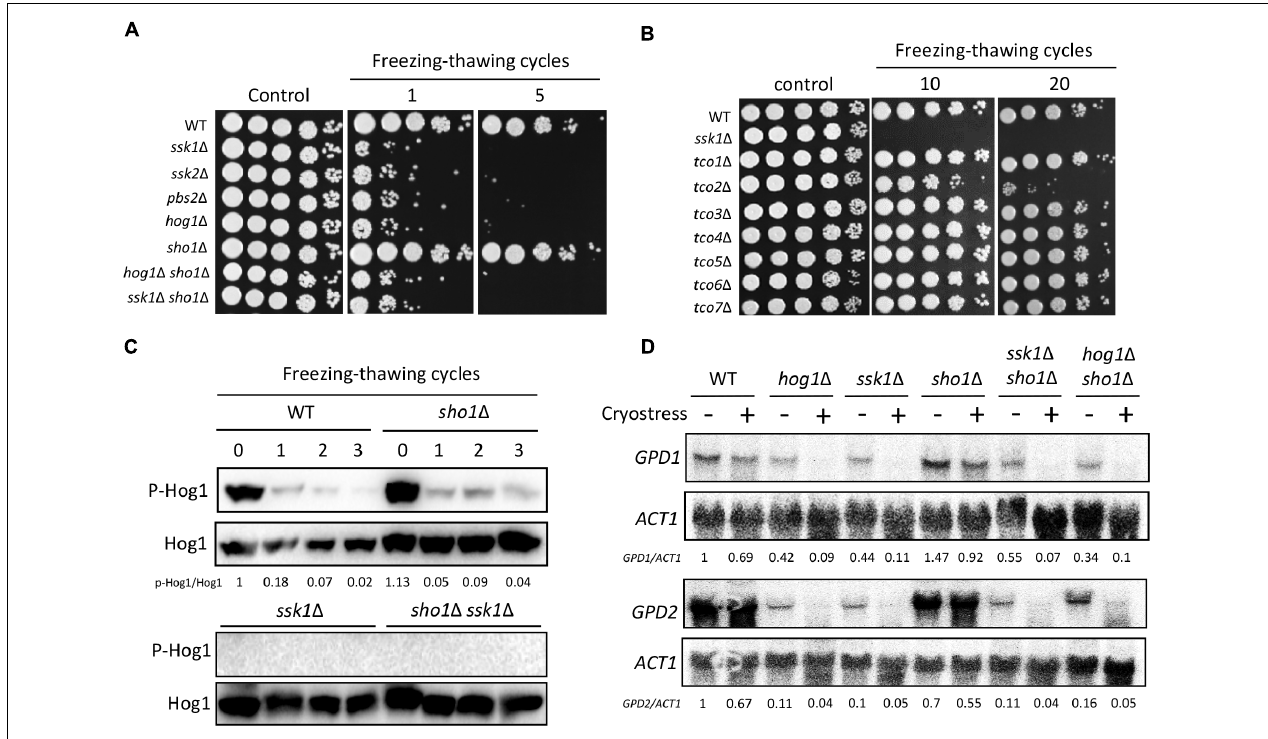
FIGURE 3 | Hog1 governs the cryostress response in a Ssk1-dependent, but Sho1-independent, the manner in C. neoformans . (A,B) Wild-type (WT; H99), ssk1 (cid:49) (YSB261), ssk2 (cid:49) (YSB264), pbs2 (cid:49) (YSB123), hog1 (cid:49) (YSB64), sho1 (cid:49) (YSB1719), hog1 (cid:49) sho1 (cid:49) (YSB2268), ssk1 (cid:49) sho1 (cid:49) (YSB2253), tco1 (cid:49) (YSB278), tco2 (cid:49) (YSB281), tco3 (cid:49) (YSB284), tco4 (cid:49) (YSB417), tco5 (cid:49) (YSB286), tco6 (cid:49) (YSB2469), and tco7 (cid:49) (YSB348) strains were grown overnight at 30 ◦ C in liquid YPD medium. The cells were frozen in liquid nitrogen for 1 min and then melted in a 30 ◦ C water bath for 15 min; this process was repeated as the indicated number of the cycle in the figure. After that, cells were 10-fold serially diluted (1–10 4 dilutions) and spotted 3 µ L on YPD medium. These experiments were repeated more than three times and the one representative image was shown here. (C) WT (H99) and sho1 (cid:49) (YSB1719) strains were grown to the mid-logarithmic phase and, then, repeated the freezing and thawing process by cycles indicated and total protein extracts were prepared for the western blot analysis. These western blot analyses were repeated twice and one representative result was shown here. (D) The northern blot analysis was performed with the total RNAs isolated from each strain by repeating two freezing and thawing cycles. Each membrane was hybridized with the gene-specific probe. The relative expression levels of GPD1 and GPD2 were quantitatively measured using a PhosphorImager after normalization with ACT1 expression levels ( GPD1/ACT1 and GPD2/ACT1 ). These northern blot analyses were repeated twice and one representative result was shown